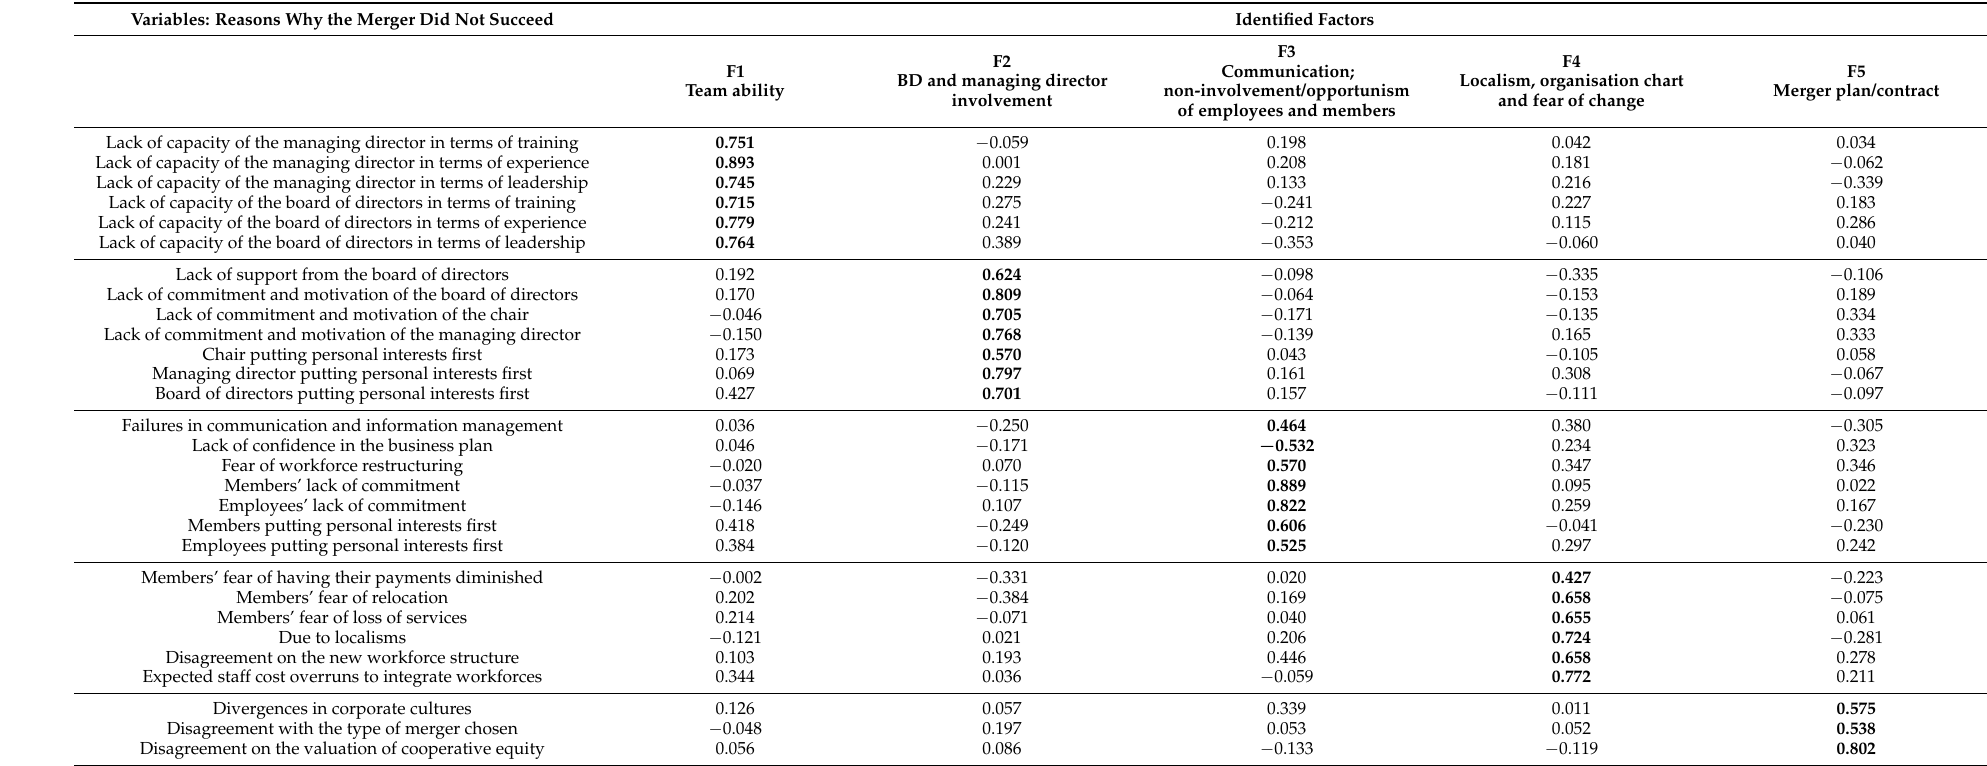
Table 7. Components derived from VARIMAX rotation in